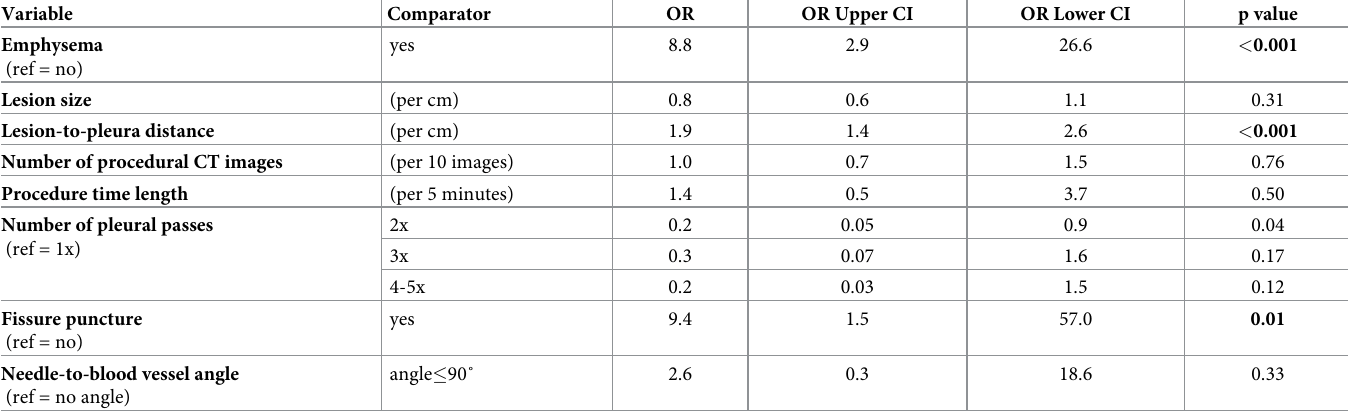
Table 5. Multivariate logistic regression analysis (no and minor complications SIR0-2 vs. major complications SIR3-4) of selected variables in the study group (n =